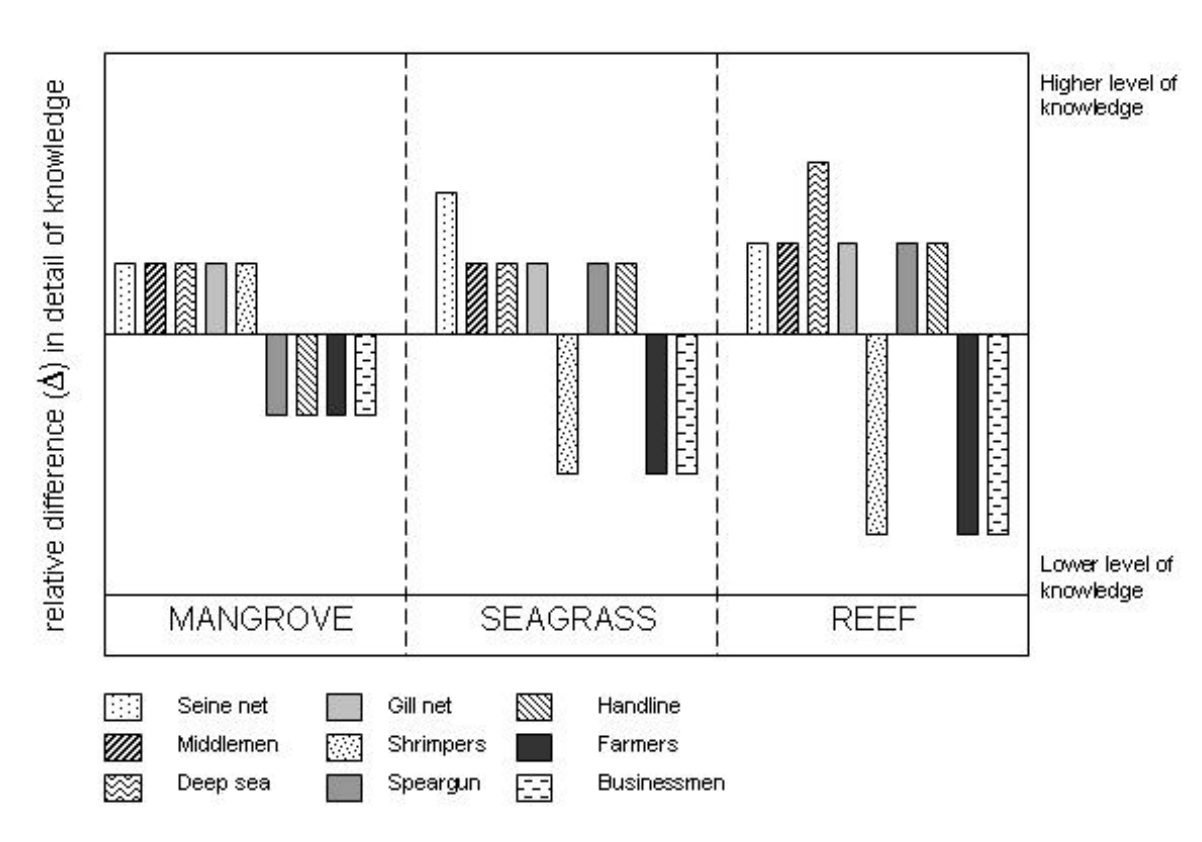
Fig. 3. Relative difference in local ecological knowledge among different occupational groups operating in the target community. Knowledge is divided into three categories based on the three recognized subcomponents of the coastal seascape; mangrove, seagrass, and reef. Knowledge of different groups for each subcomponent is represented as the relative difference of their level of knowledge compared to an estimated average level of knowledge for all groups, i.e., the baseline in the figure. Thus, the bars represent each group’s knowledge in relation to other groups. Amount of knowledge, for each occupational category, is ranked based on the expressed level of detail of ecological components and processes. Although groups may be represented as having equal levels of knowledge in terms of detail, the actual content of the knowledge may at times be related to different species depending, for example, on which species are primarily targeted by a specific